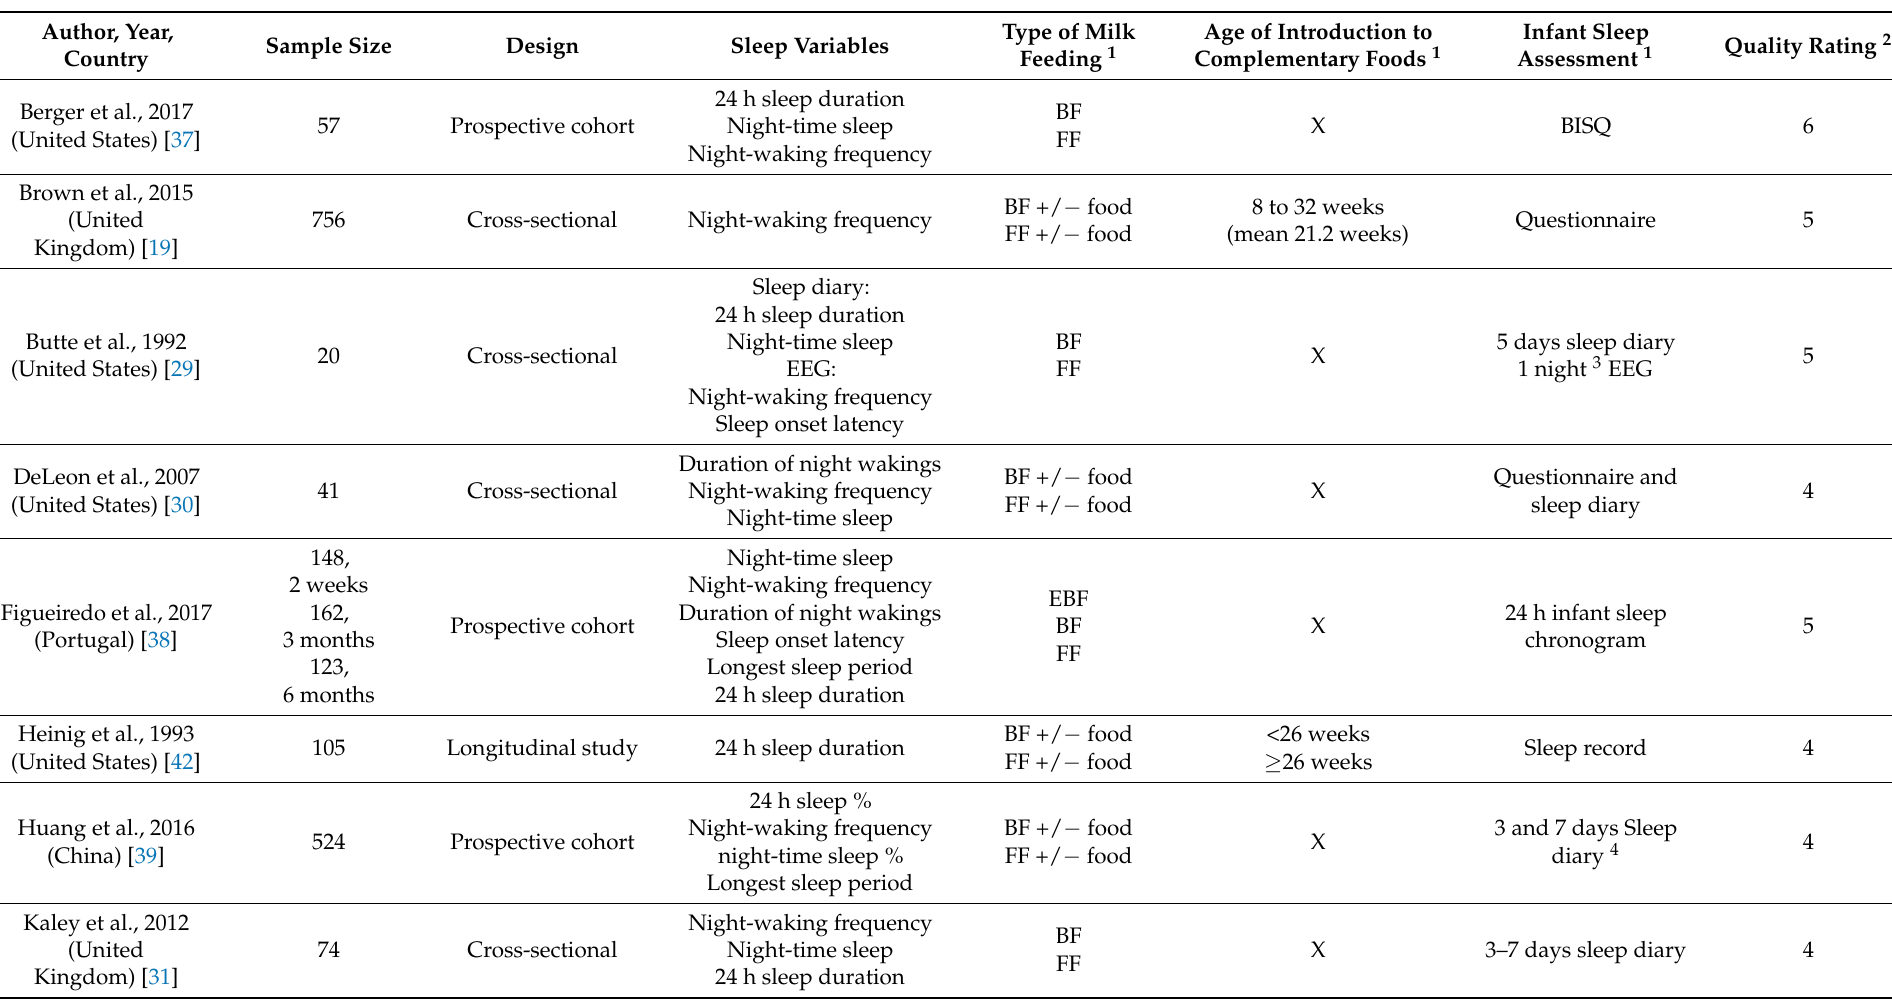
Table 1. Characteristics of studies included in the systematic review by study details, types of sleep variables, type of milk feeding, age of introduction to complementary foods, types of sleep assessment methods, and quality rating ( n =